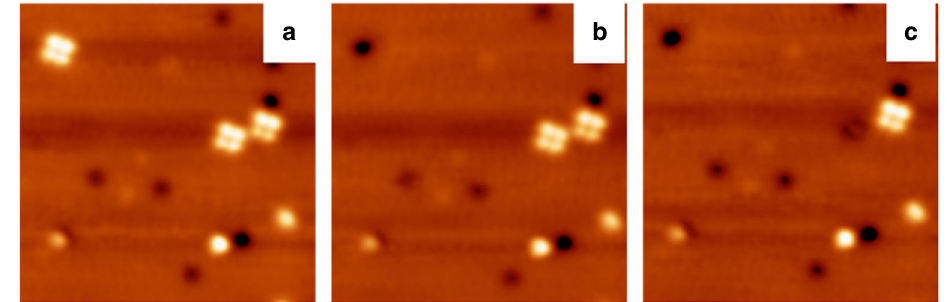
Fig. 6 Controllable successive tip manipulation experiments. a A STM topographic image includes three tetramers. b After a pulse is applied, the tetramer located at the top left corner disappears. c One more tetramer disappears upon further tip pulsing. To conduct the tip manipulation, a voltage pulse of − 3.2 V between STM tip and molecules was applied. The image sizes are 22 nm × 22 nm and the scanning parameters are V b = 1 V, I t = 20 pA for all the